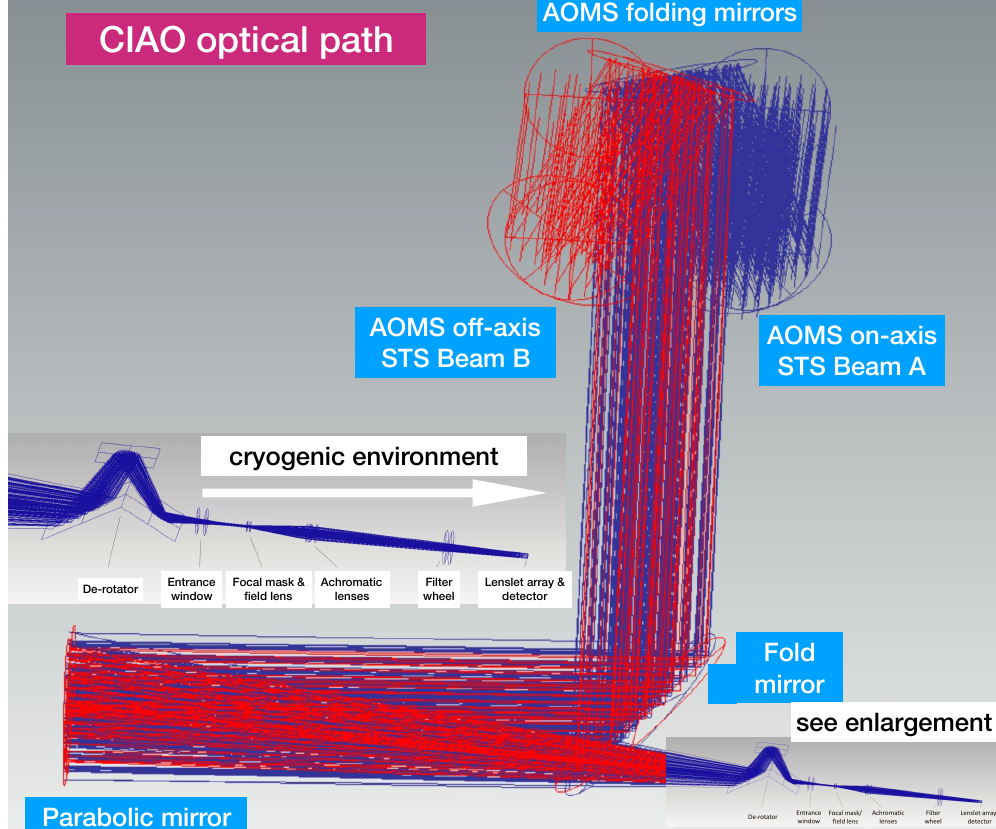
Figure 3. Using the adaptive optics (AO) mode selector (AOMS), each CIAO unit can select either STS beam A or B as optical input channel. The light from the selected channel is then relayed via a fold mirror and a parabolic mirror through a de-rotator unit (K-mirror design) into the CIAO wavefront sensor cryostat. The cryogenic part on the lower right side is shown enlarged on the left side in the middle below the label cryogenic